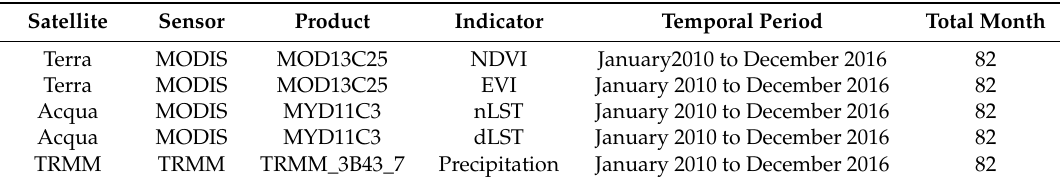
Table 1. MODIS and TRMM Satellite data used in this